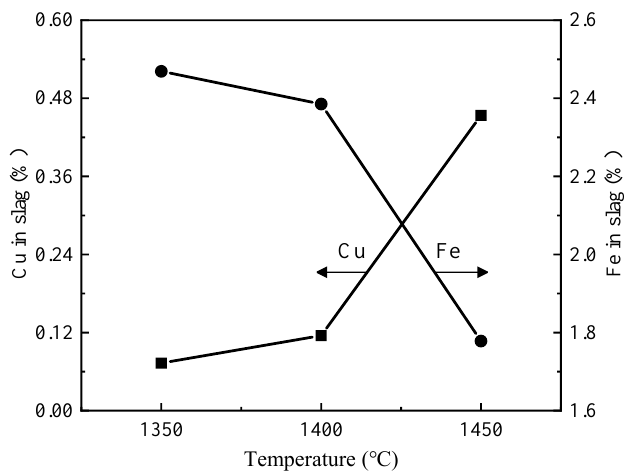
Figure 10. Effect of temperature on the copper and iron contents in the reduced slag by experiments, 5% CaO and 13% graphite.